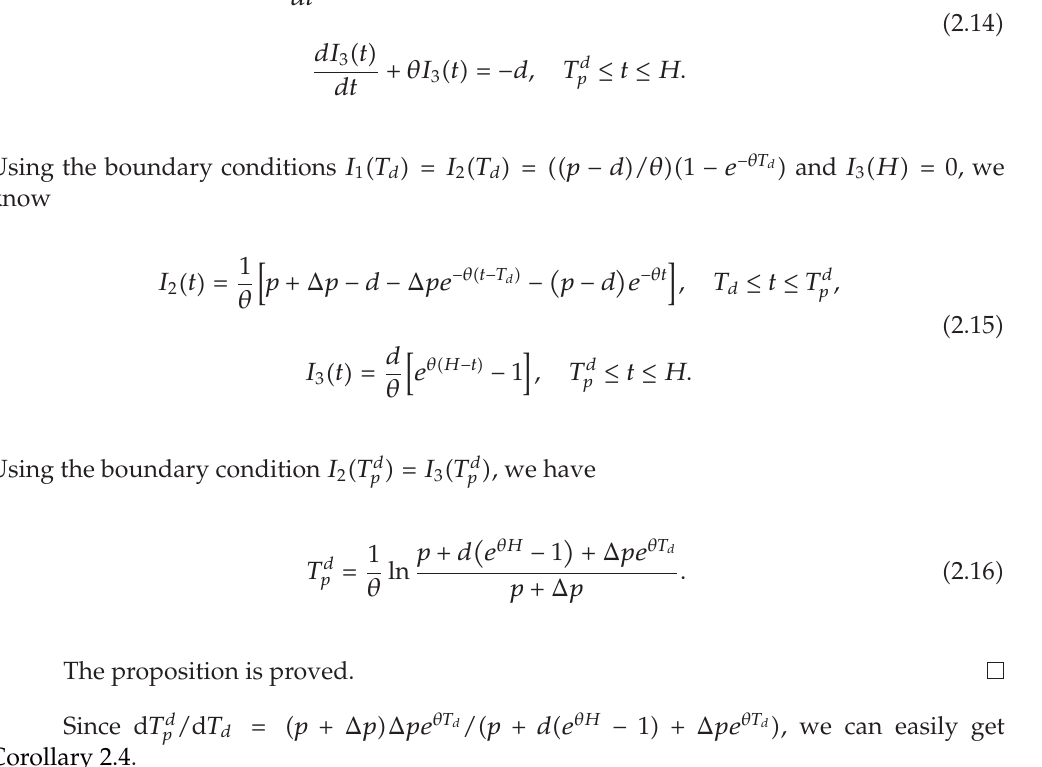
∈ (cid:3) T (cid:4)(cid:6) d ,H p